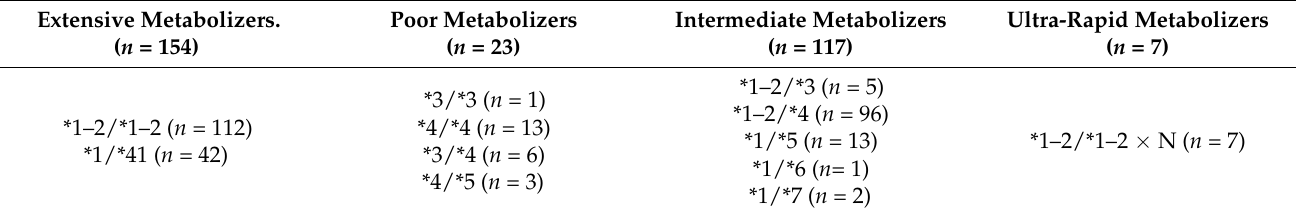
Table 1. CYP2D6 genotypes and phenotypes in the study population. Extensive